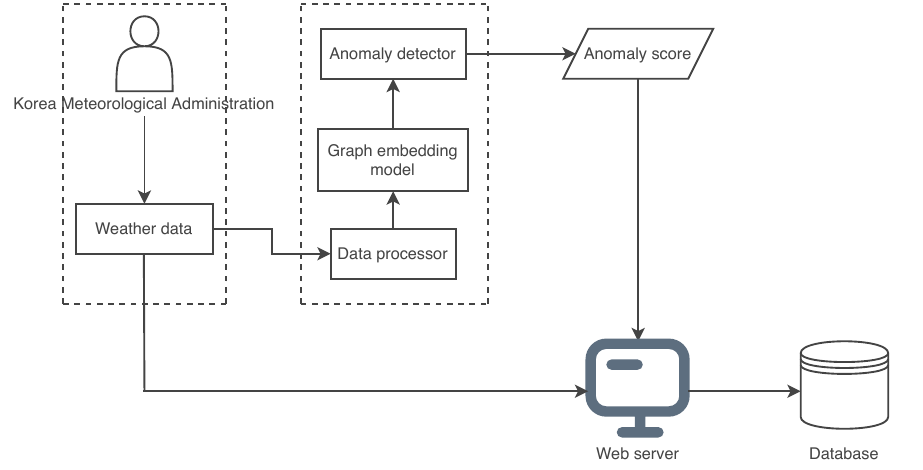
Figure 1. Back-end